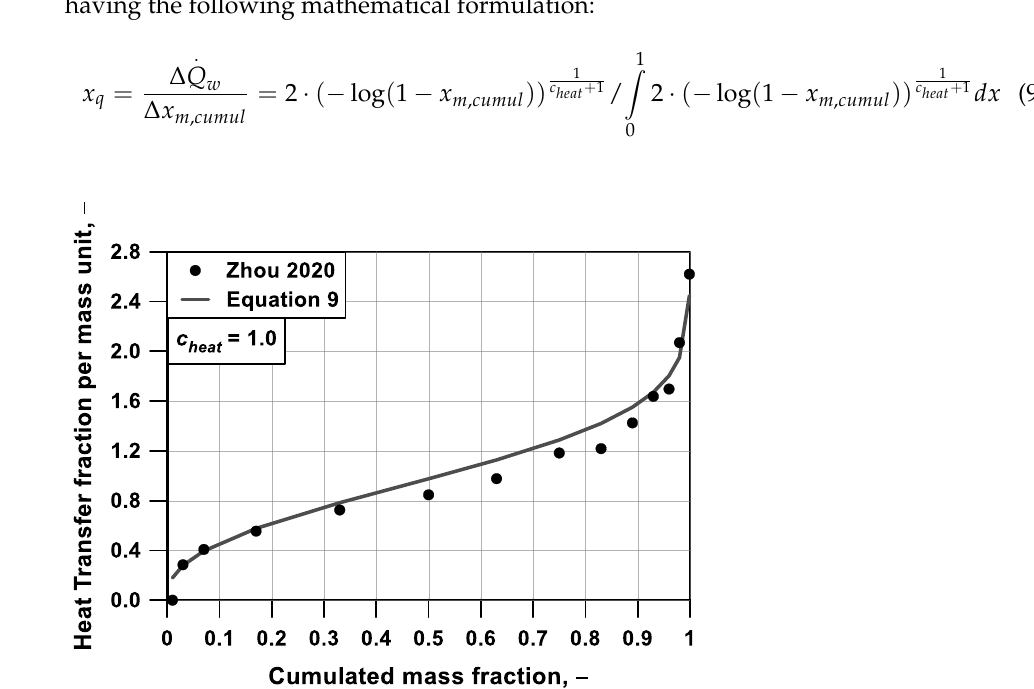
Figure 3. Distribution of heat transfer fraction per unit mass versus the cumulative mass fraction ( a ) and the corresponding zonal heat transfer fraction ( b ).